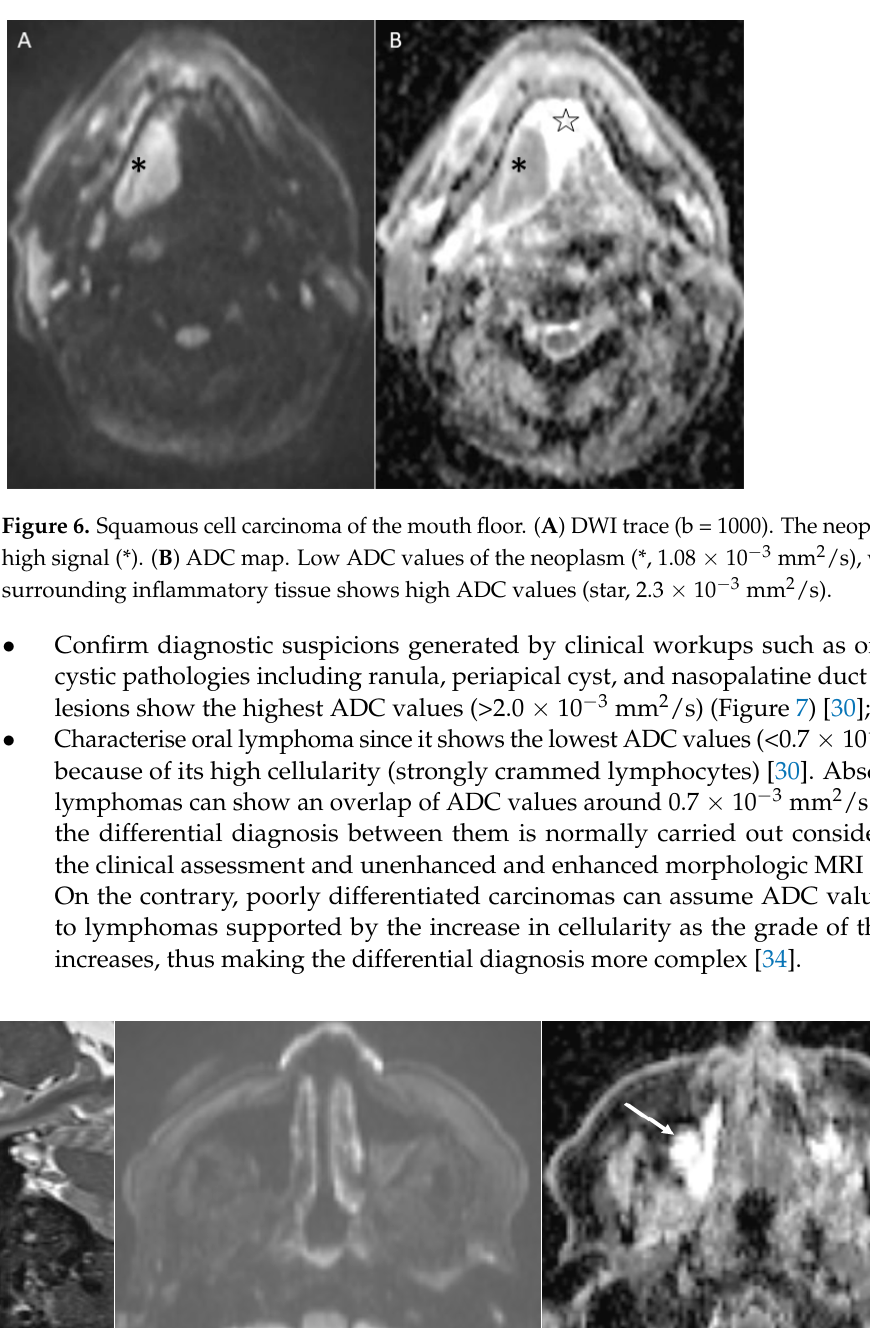
Figure 7. Periapical cysts. MRI . ( A ) Sagittal T2 image. ( B ) DWI trace b = 1000. ( C ) ADC map. Periap- ical cyst (white arrows) results from dental infections that spread to the tooth apex and into the adjacent bone. It is often bordered by a thin rim of cortical bone as can be observed in ( A ). In ( B , C ) the absence of restricted diffusion is highlighted since no hyperintense signal on DWI trace and high values on ADC map (2.27 × 10 − 3 mm 2 /s) are found.